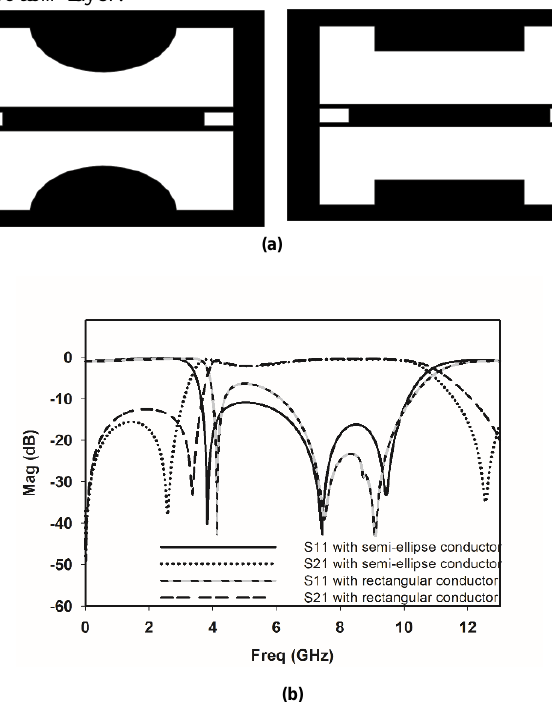
FIGURE 7. (a) Bottom layer with rectangular and semi-ellipse conductor, (b) Compared S-parameters.